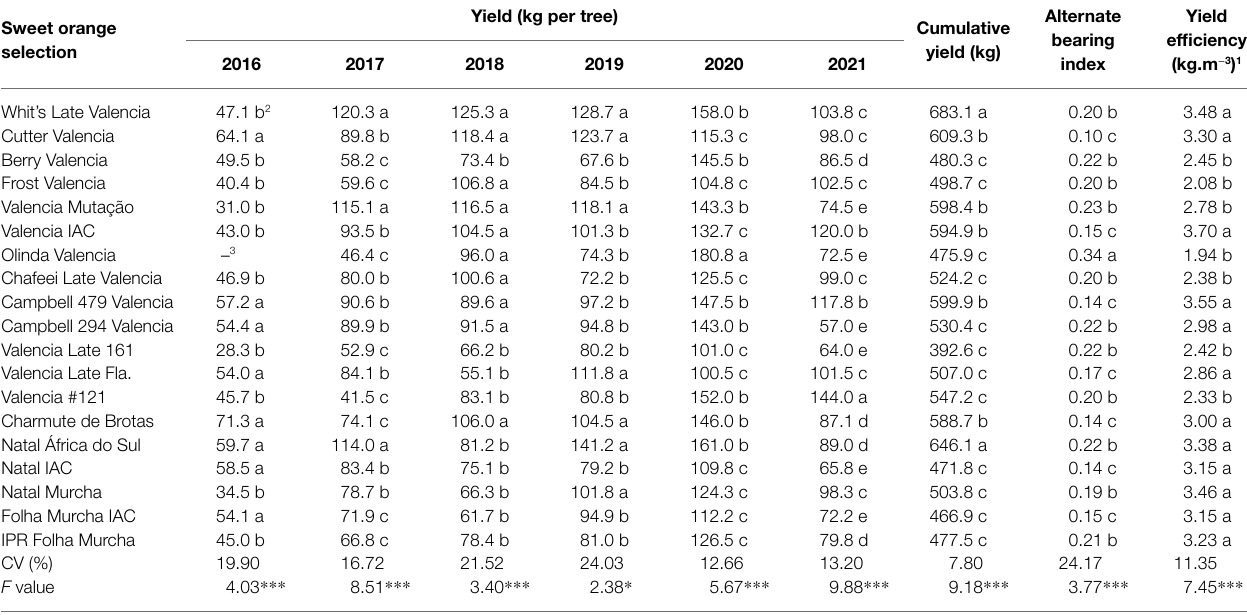
Yield (kg per tree)